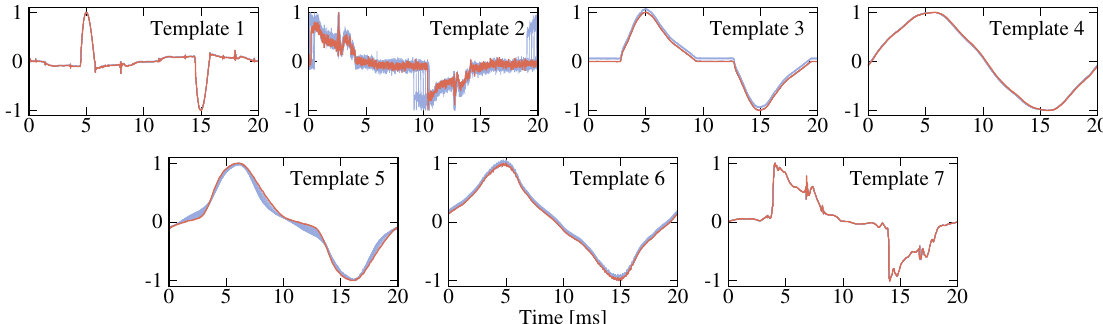
Figure 7. Visualization of the seven most representative templates extracted for the COOLL data set; besides the highlighted template trajectories, the plots show the contributing waveforms in light